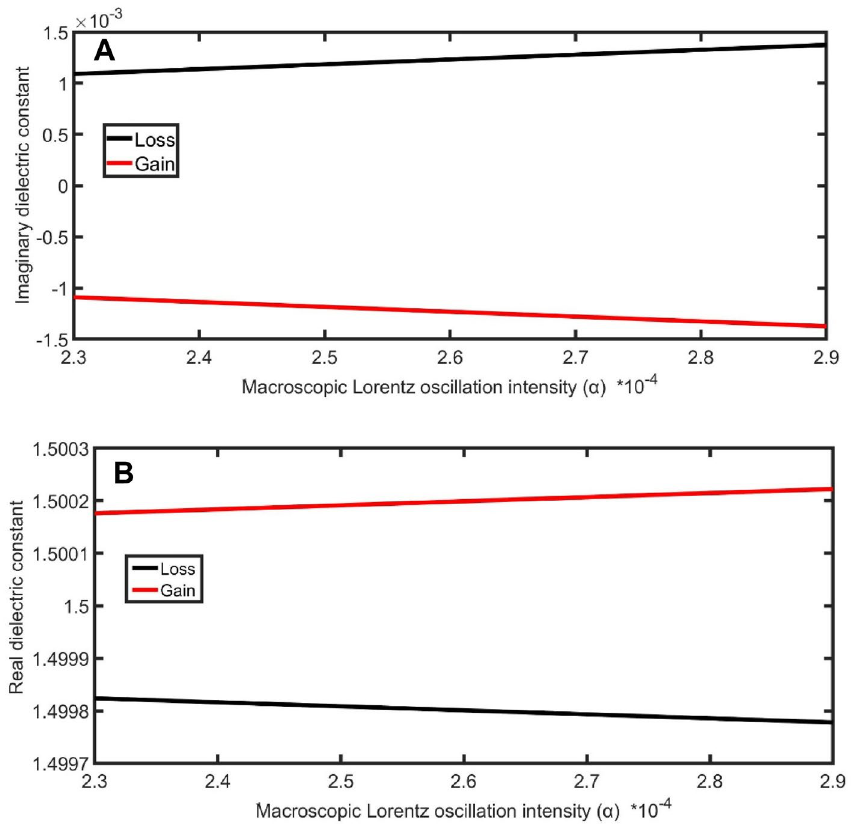
Figure 6. The impact of α on ( A ) imaginary dielectric constant, ( B ) real dielectric constant at 1525 nm as a function of macroscopic Lorentz oscillation intensity.